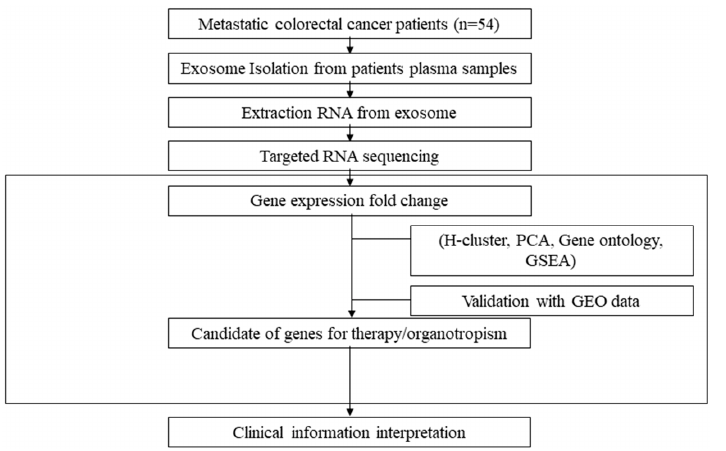
Figure 1. Overview of the plasma exosomal RNA analysis workflow. Abbreviations: PCA, principal component analysis; GSEA, gene set enrichment analysis; and GEO, gene expression omnibus.